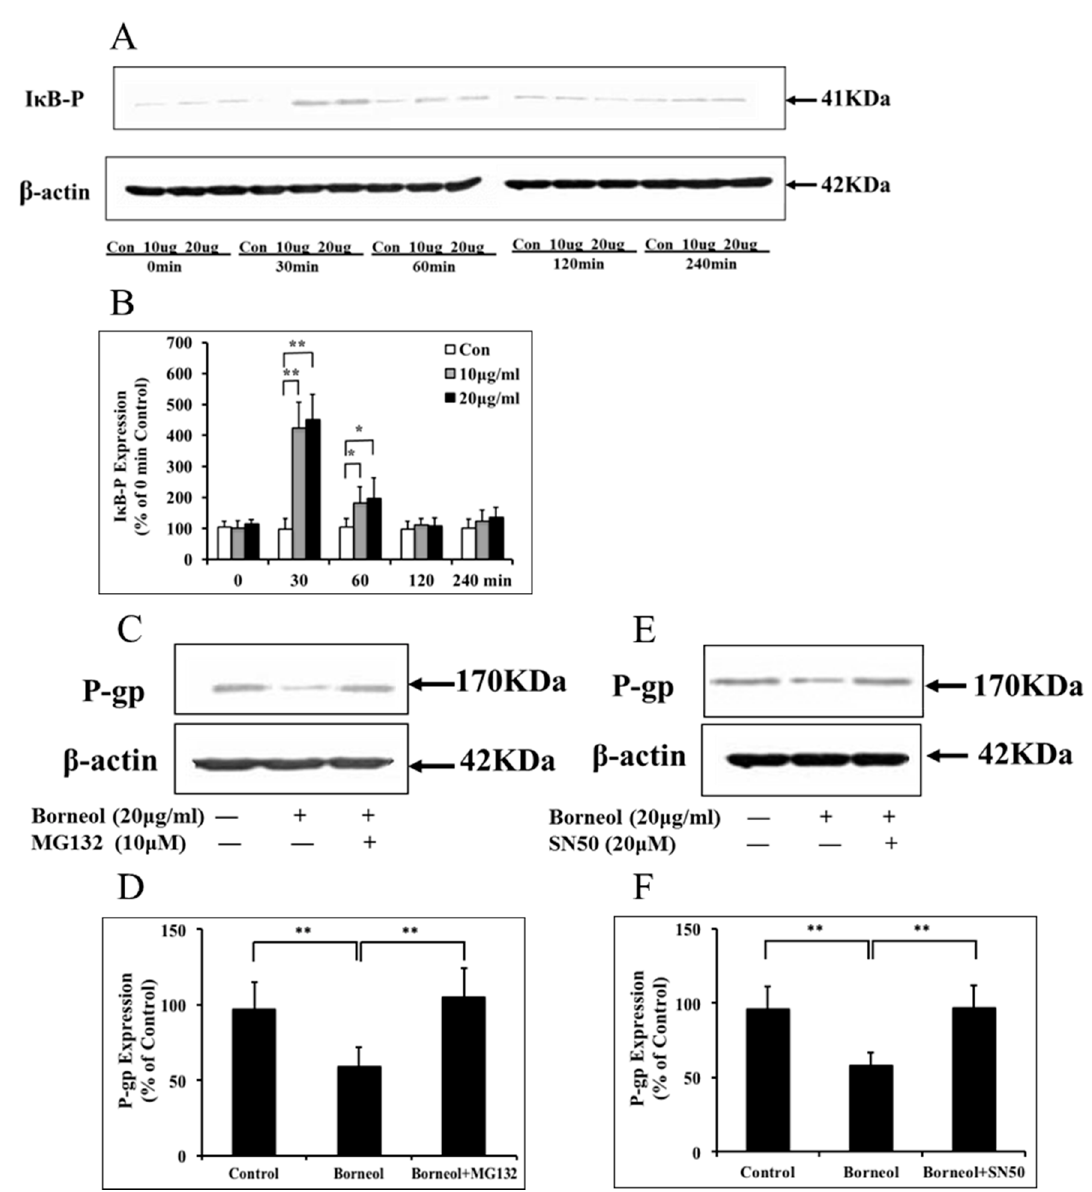
Figure 5. Measurement of NF- κ B expression in BMECs. ( A ) Representative phosphorylated I κ B expression by Western blot on BMECs treated with borneol up to 4 h; ( B ) Quantitative data of phosphorylated I κ B expression; ( C ) Representative P-gp expression by Western blot on BMECs treated with borneol and borneol + MG132, respectively; ( D ) Quantitative data of P-gp expression; ( E ) Representative P-gp expression by Western blot on BMECs treated with borneol and borneol + SN50, respectively; ( F ) Quantitative data of P-gp expression. Data are expressed as mean + SD; * p < 0.05, ** p < 0.01 ( n = 3 per group).